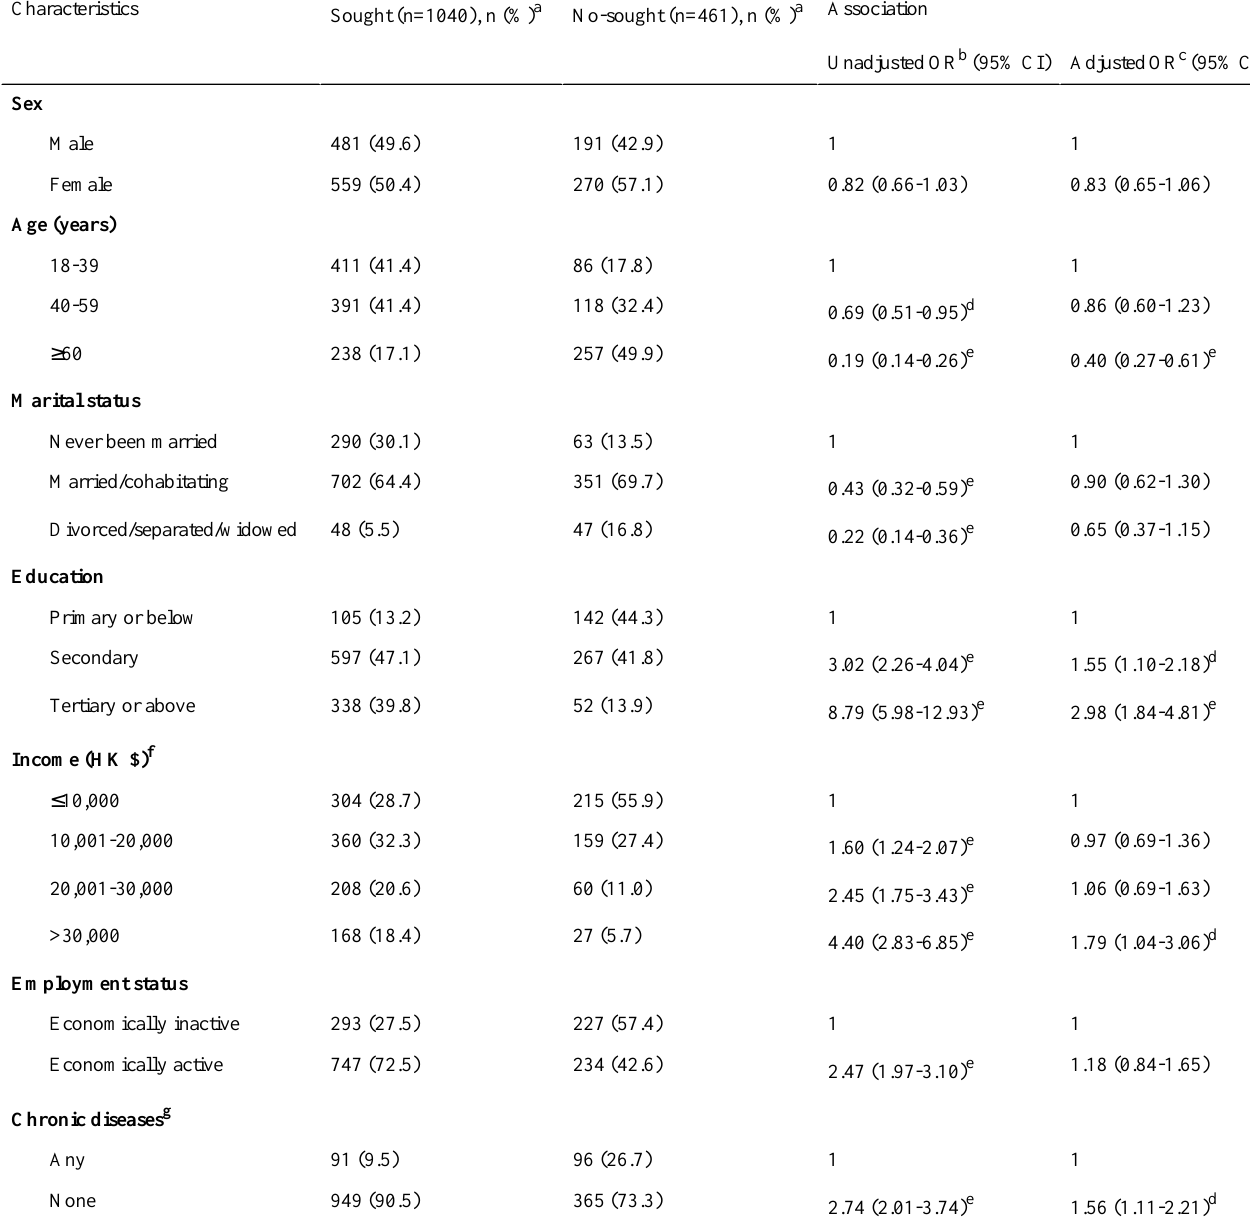
Table 2. Associations among demographic variables, socioeconomic status, and chronic disease with seeking of web-based information on COVID-19